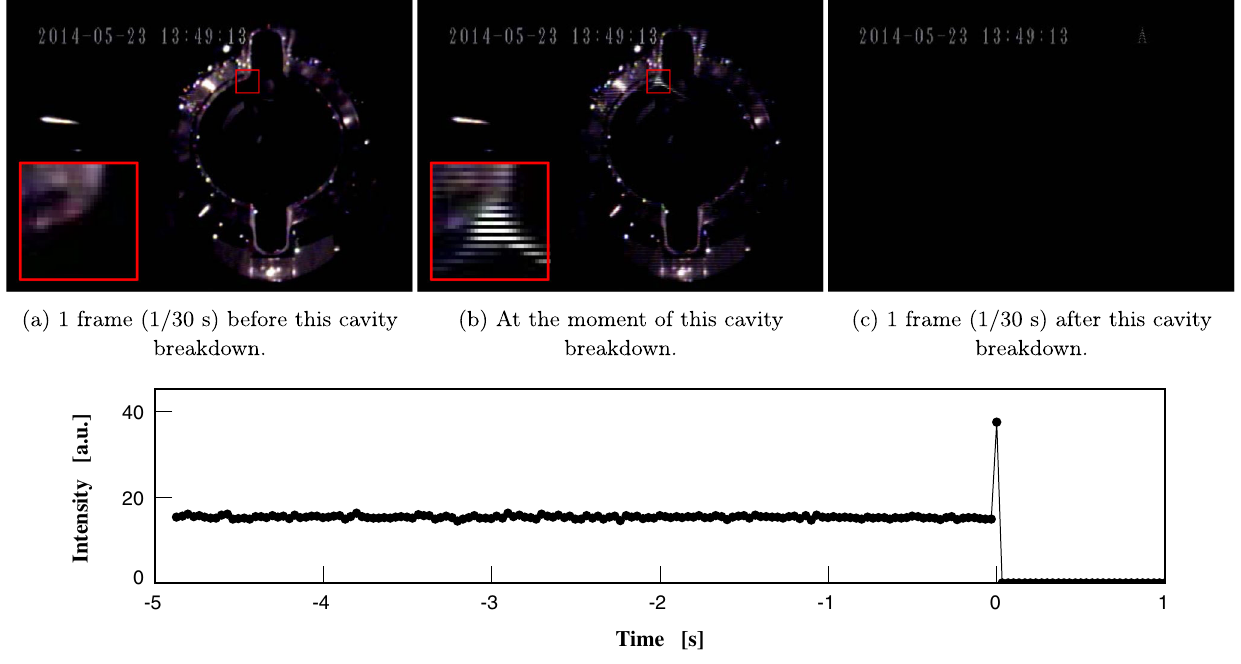
FIG. 12. Example of spot-type explosion events without a stable bright spot. (a), (b), and (c) are snapshots, in chronological order, of the FEP recorded with TV camera 3 during the rf conditioning. The insets are magnified views of the region outlined by a red square. A spot-type explosion occurred at 11 o ’ clock [inside the red square in (b)] at V c ¼ 0 . 65 MV; however, no bright spot was present in this region until one frame before this cavity breakdown, as indicated by the red square in (a). A clear spike was observed in the intensity of the region outlined by a red square at the moment of this cavity breakdown, as shown in